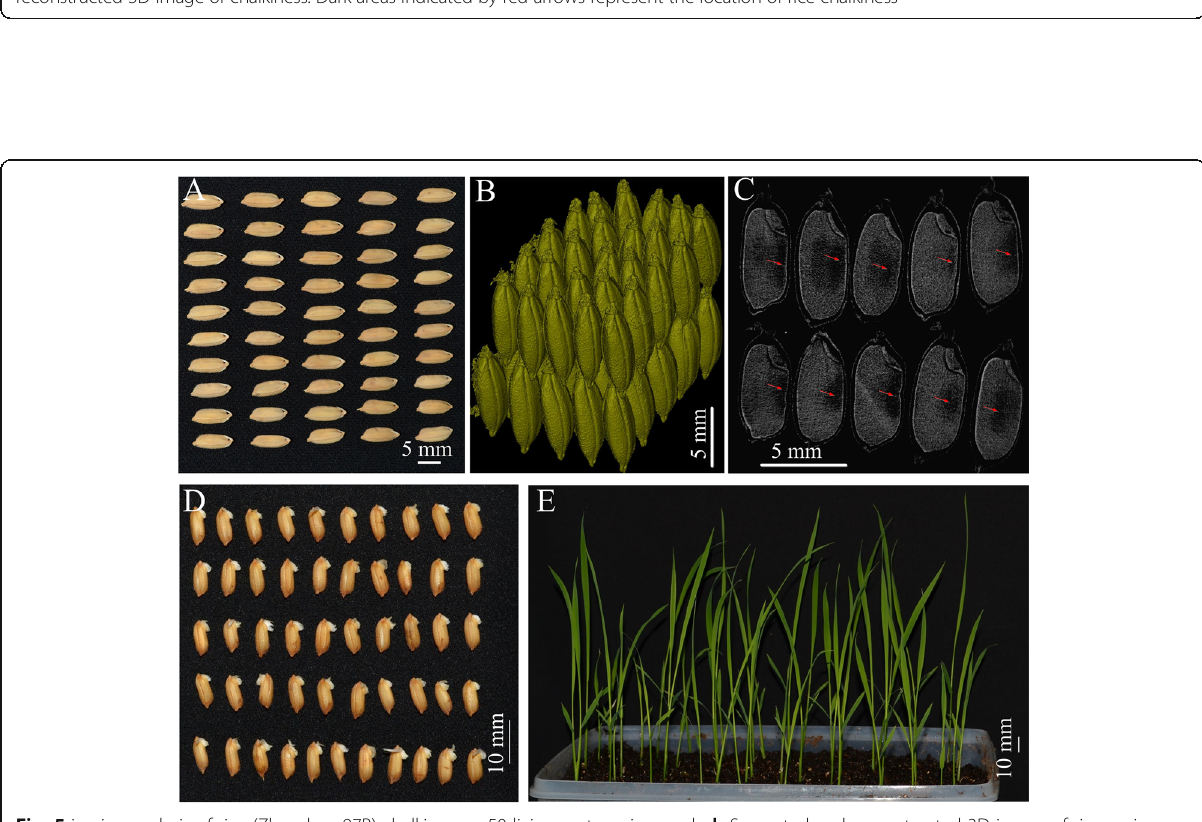
Fig. 4 High-throughput analysis of 3D rice chalkiness by using micro-CT scan and 3D reconstruction. a Milled rice (Zhenshan 97B); b Milled rice were embedded in Super Light Clay (about 2cm×2cm×2cm); c One cross-section of milled rice grains under 13.5 μ m resolution, and the red arrows represent the location of rice chalkiness; d Separated and reconstructed 3D image of milled rice embedded in Super Light Clay; e Separated and reconstructed 3D image of chalkiness. Dark areas indicated by red arrows represent the location of rice chalkiness